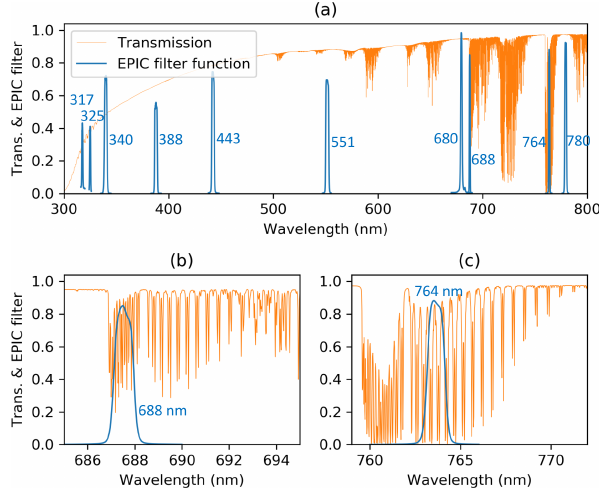
Figure 1. EPIC instrument filter response function (blue) and at- mospheric spectral transmission (orange). Panel (a) includes all 10 EPIC bands, whereas panels (b) and (c) show zoomed-in views for the 688nm channel in the O 2 B band and the 764nm channel in the O 2 A band, respectively. Here the atmospheric transmission is simulated by the UNL-VRTM, with a spectral step size and a spectral full-width at half maximum of